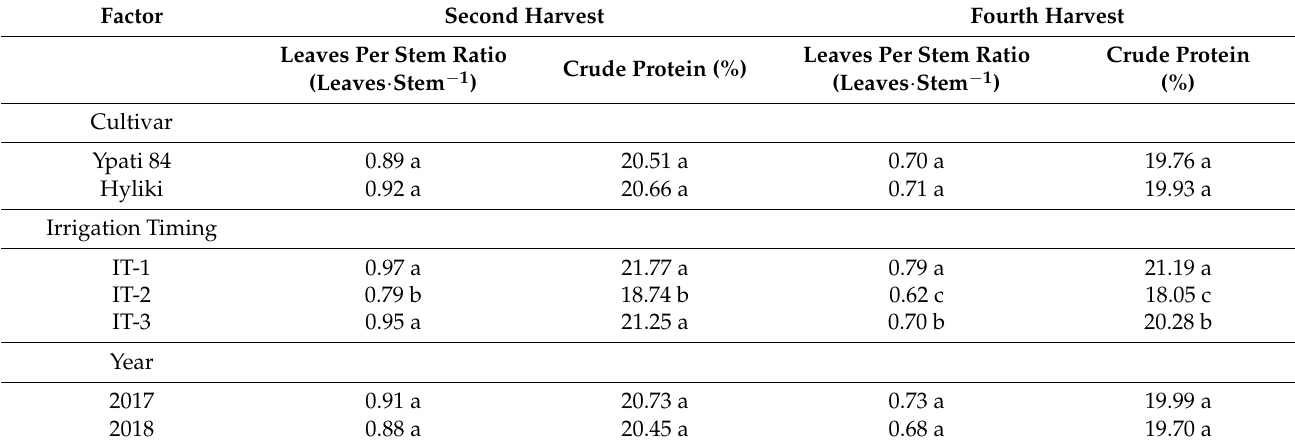
leaf per stem ratio than the irrigation performed 1 week after the third clipping (IT-2). Table 10. The leaves per stem ratio (leaves · stem − 1 ) and crude protein (%) values recorded, in the second and the fourth harvest, across the two experimental